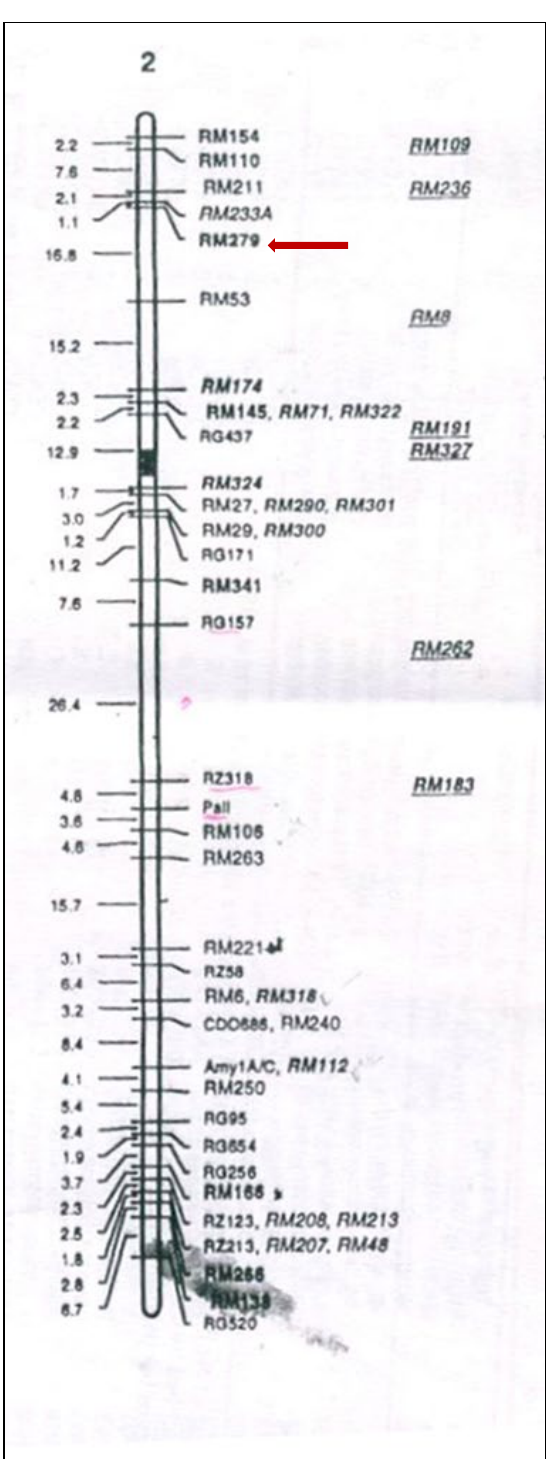
Supplemental Figure 5: Map position of markers RM277 and RM279 on rice chromosomes 12 and 2. (adapted from Temnykh et al .,